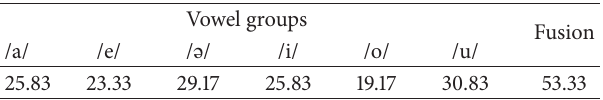
Table3:Vowel-basedageestimationaccuracy(inpercentage)based on different activation functions and fusion of the results using the proposed fuzzy information fusion method.